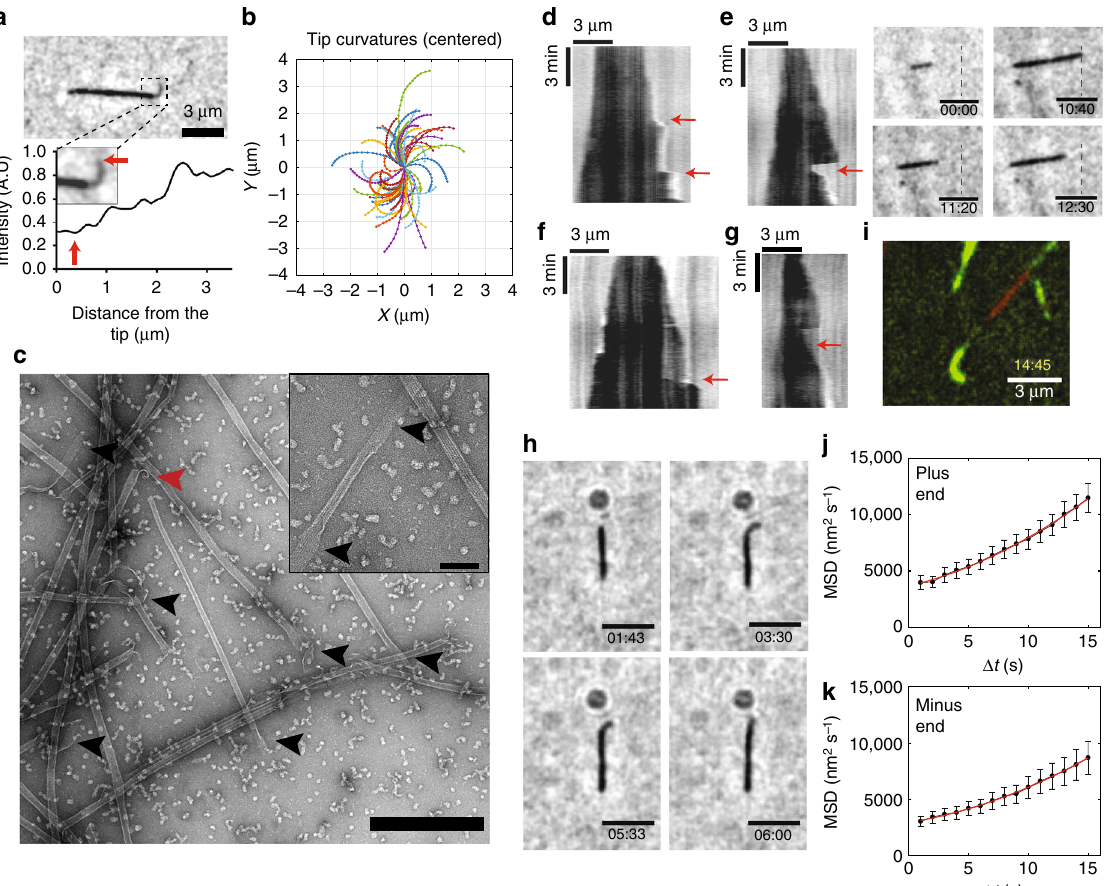
Fig. 4 Growth of curved proto fi laments polymerized from axonemal tubulins. a An image of curved PFs (dim region) growing from a MT (top). Intensity pro fi le of the MT tip shows stepwise increases (bottom). Red arrow indicates the tip. b Traces of individual curved PFs. c TEM image of growing MTs with open sheets at the ends (indicated in black arrows), and shrinking MT with ram ’ s horns (red arrow). Scale bar: 500 nm. Inset: high magni fi cation of MT with open sheets at its ends. Scale bar: 100 nm. d Kymograph showing fast growth phases. e Kymograph and images showing fast growth phase after catastrophe event (dashed red line as reference). f Kymograph showing the growth of a few PFs (dim region) and the growth of additional PFs alongside them. g Kymograph showing stable PFs after catastrophe event. Red arrows indicate each event. h Images showing the formation of curved tip structure following a catastrophe event. i TIRF microscopy image showing a curved tip structure (see also Supplementary Movies 9 and 10). j , k Mean-squared displacement (MSD) against time. A quadratic fi t yielded a diffusion coef fi cient and velocity at the plus and minus ends